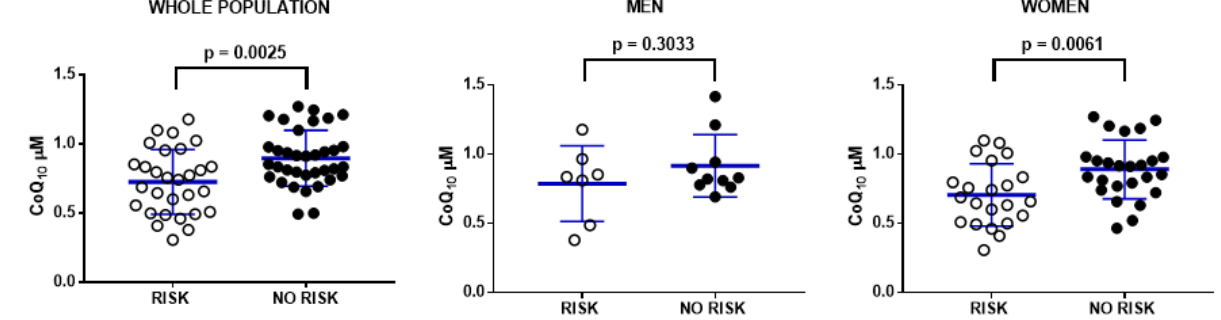
Figure 3. Blood plasma CoQ 10 levels ( μ M) in the participants in relationship with their respective cardiovascular risk determined by a total cholesterol/HDL quotient higher than 4 (risk) or lower than or equal to 4 (no risk). Data represent the mean ± SD of the whole population (n = 64), men (n = 17) and women (n = 47). Table 5. Physical activity